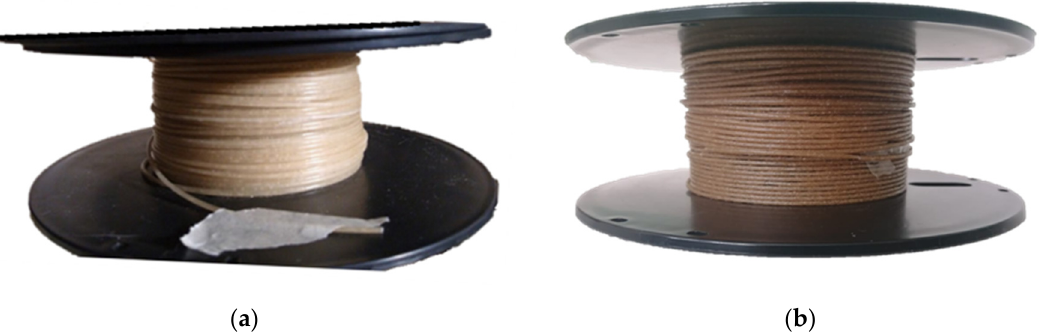
Figure 1. rPP/RH 3D printing filaments with ( a ) 5 wt.% and ( b ) 10 wt.% of